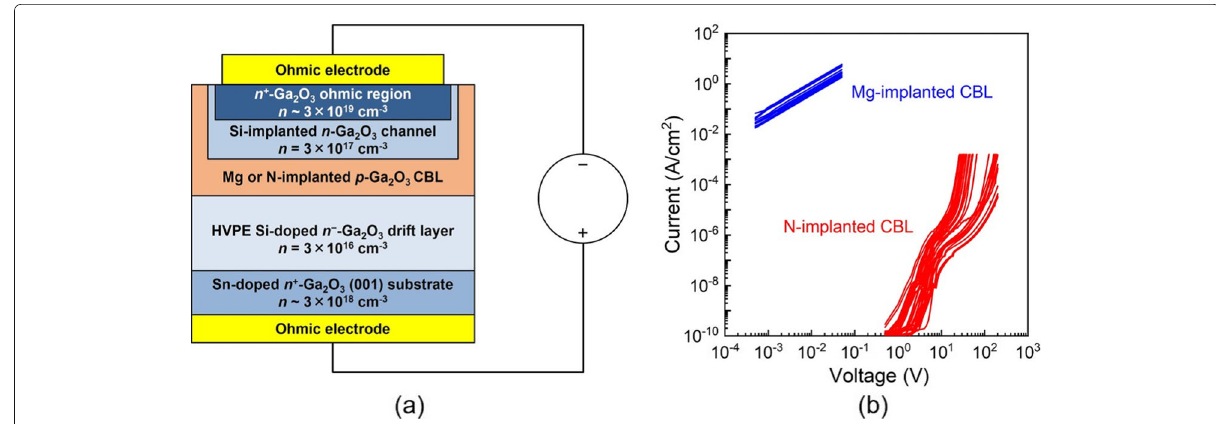
Fig. 7 a Schematic cross section of test structure with CBL fabricated using Mg- or N-ion implantation doping and b its vertical leakage current